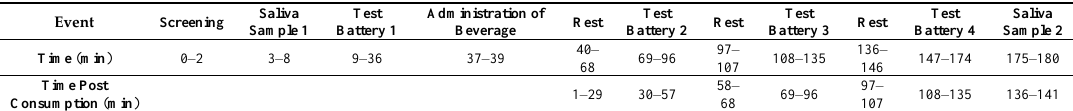
Figure 3. Test day timeline.